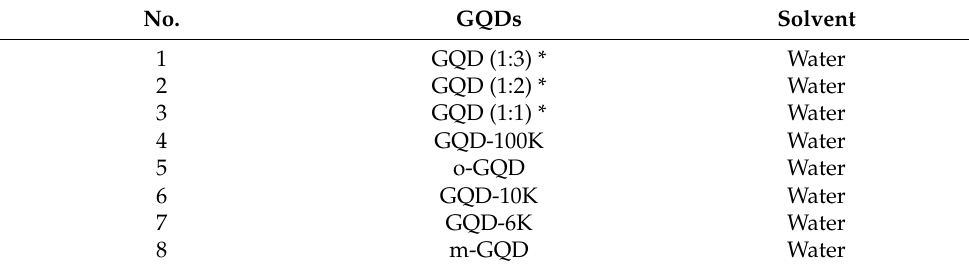
Table 1. 8 PEG-coated GQD clusters synthesized and utilized in this study. No. GQDs Solvent 1 GQD (1:3) * Water 2 GQD (1:2) * Water GQD (1:1) * Water Water